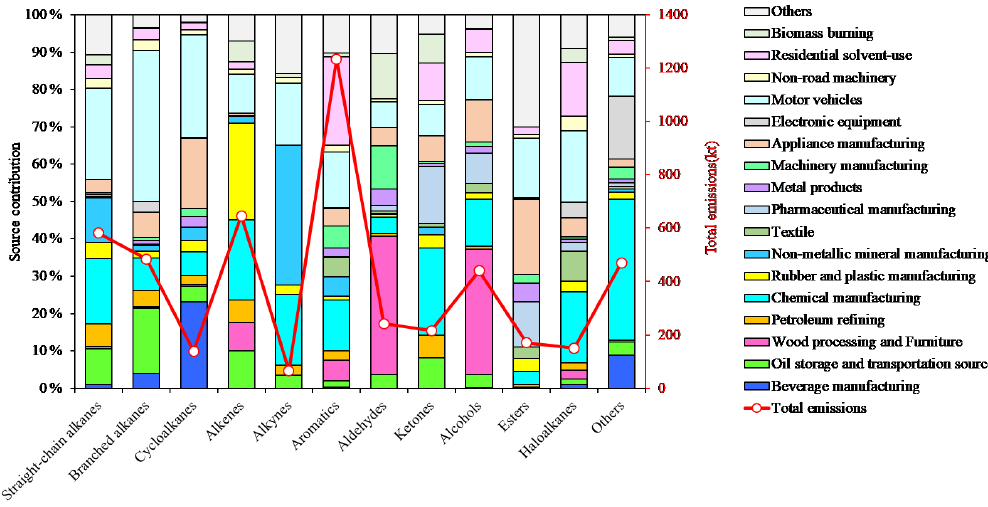
Figure 7. Major source contributions of species comprising NMVOC in the YRD